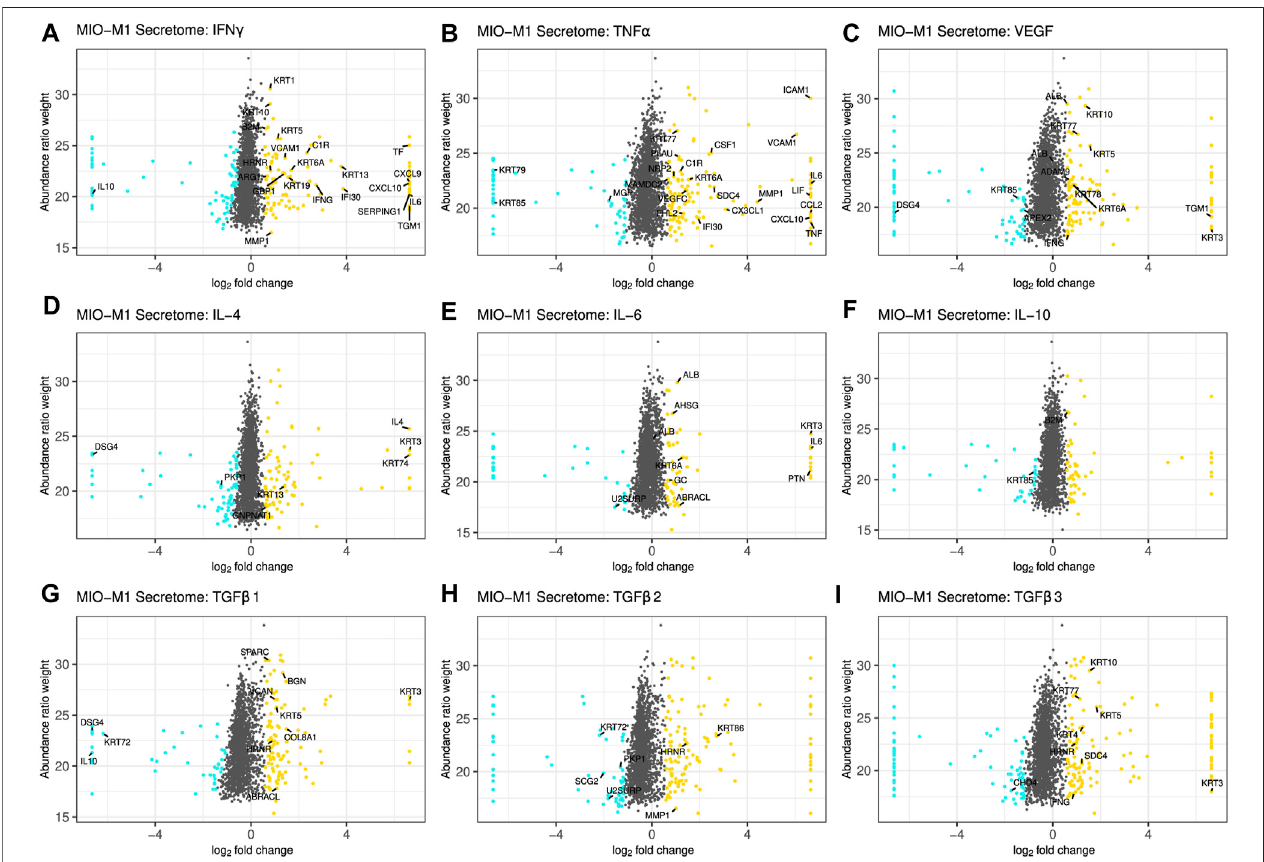
FIGURE 1 | Scatterplot of all identi fi ed proteins from MIO-M1 secretomes after treatment with the indicated cytokines for 24 h (A – I) . Proteins with signi fi cant changes in their abundance ( ± log2 (1.5) fold expression, corrected p -value ≤ 0.05) were colored, with upregulated proteins being depicted as yellow dots, while down- regulated proteins are colored cyan. Proteins with signi fi cantly altered abundance in both, MIO-M1 and pRMG secretomes, are labeled with their gene symbol. Keratins were excluded.